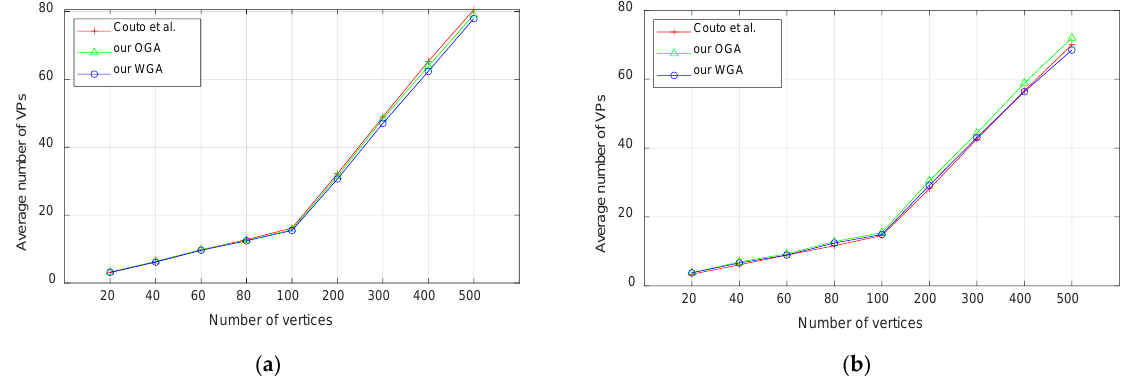
Figure 8. Average number of optimal viewpoints for ( a ) Random orthogonal polygons; ( b ) Random simple polygons.